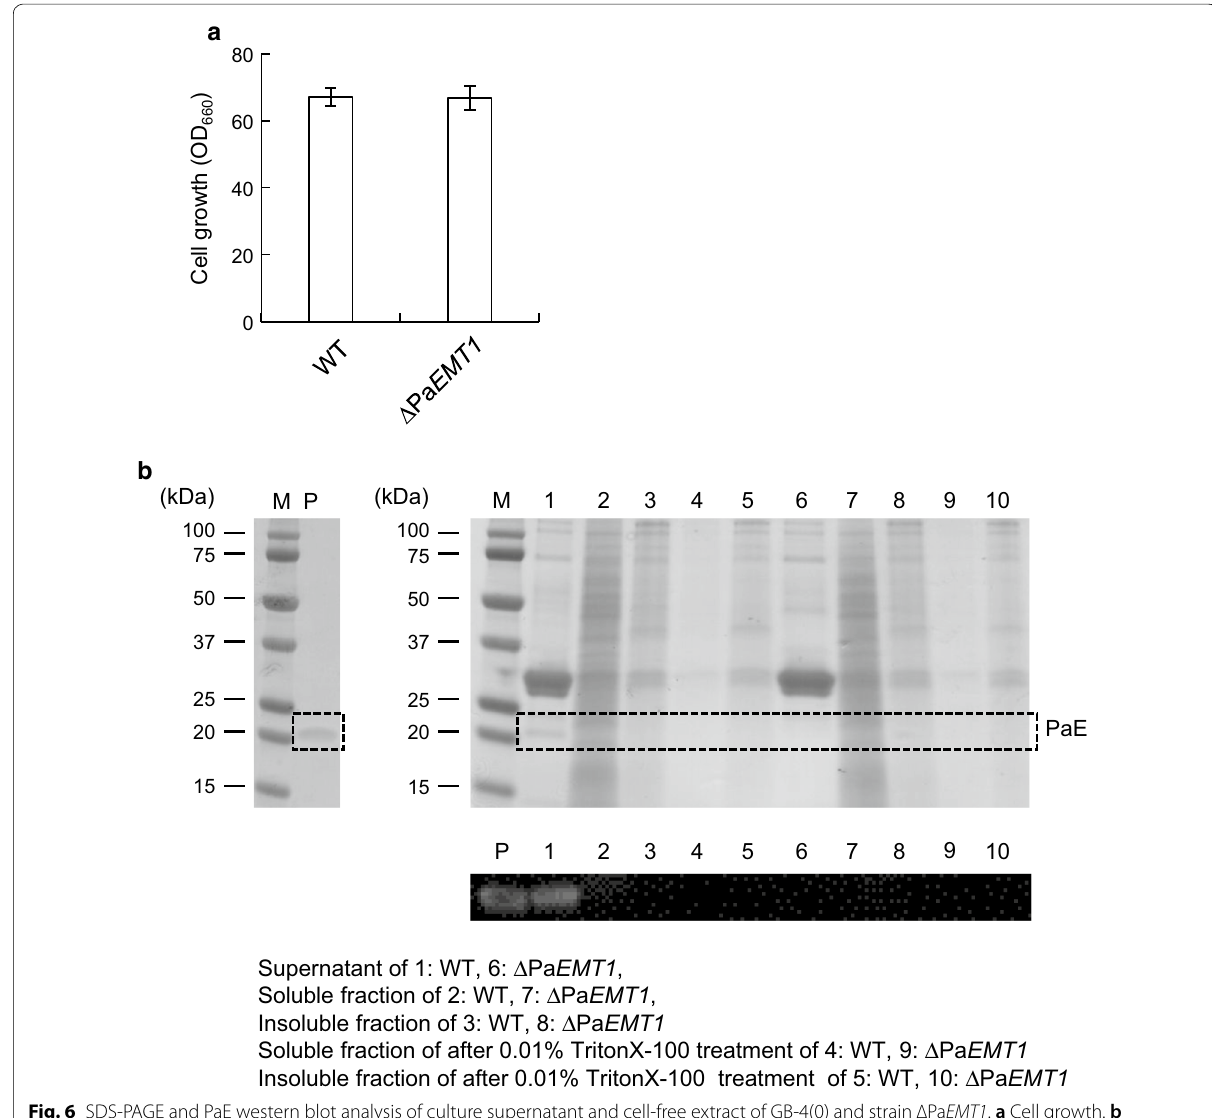
Fig. 6 SDS-PAGE and PaE western blot analysis of culture supernatant and cell-free extract of GB-4(0) and strain ∆Pa EMT1 . a Cell growth. b SDS-PAGE and PaE detection through western blot analysis. M, marker; P, purified PaE; Lane 1, supernatant of wild-type; Lane 2, soluble fraction of wild-type; Lane 3, insoluble fraction of wild-type; Lane 4, soluble fraction after 0.01% TritonX-100 treatment of wild-type; Lane 5, insoluble fraction after 0.01% TritonX-100 treatment of wild-type; Lane 6, supernatant of ∆Pa EMT1 ; Lane 7, soluble fraction of ∆Pa EMT1 ; Lane 8, insoluble fraction of ∆Pa EMT1 ; Lane 9, soluble fraction after 0.01% TritonX-100 treatment of ∆Pa EMT1 ; Lane 10, insoluble fraction after 0.01% TritonX-100 treatment of ∆Pa EMT1 . The amount of each sample loaded in the gel was 20 μL for CBB staining and western blotting. Error bars show standard